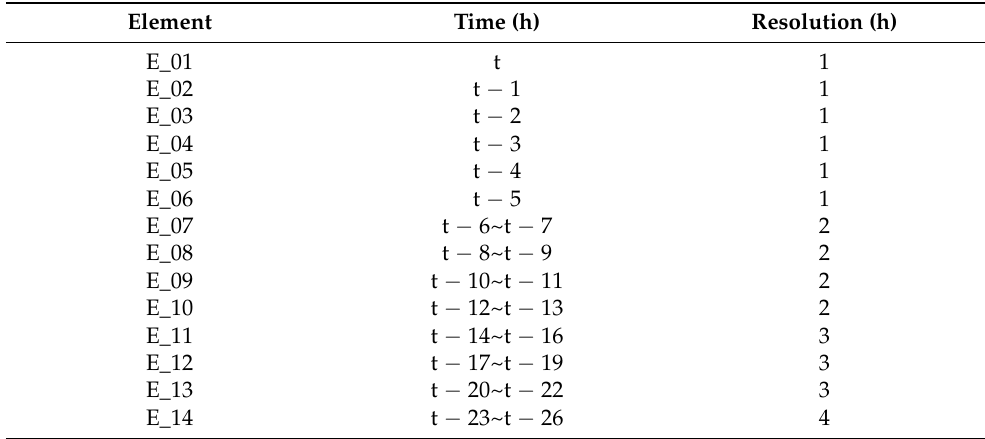
Table 3. Time elements prior to current time t and their time resolutions.